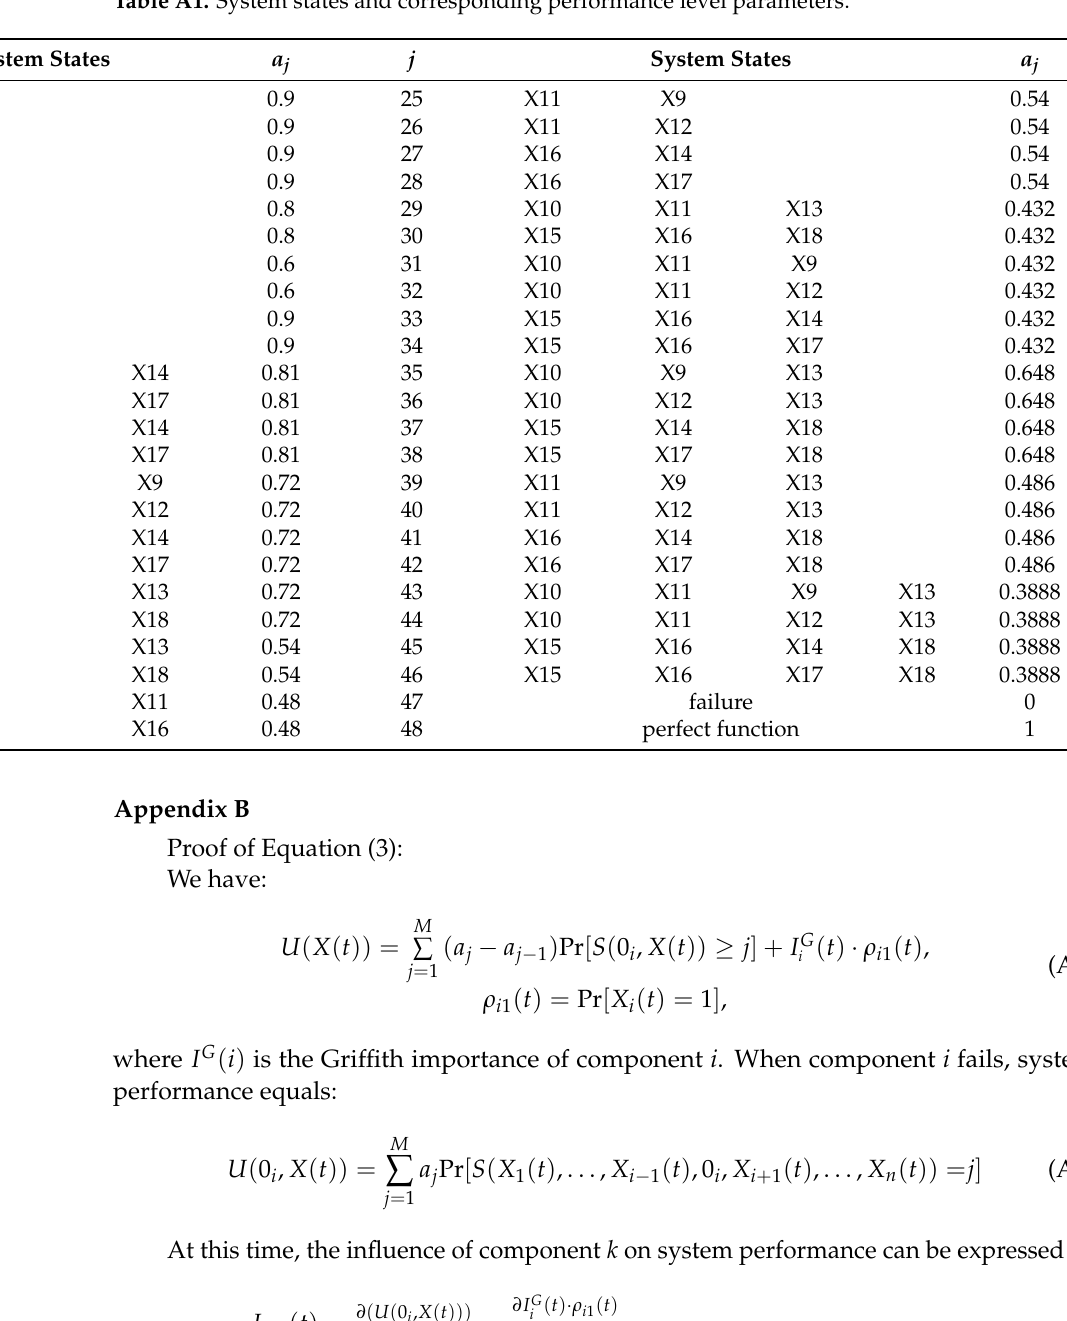
Table A1. System states and corresponding performance level